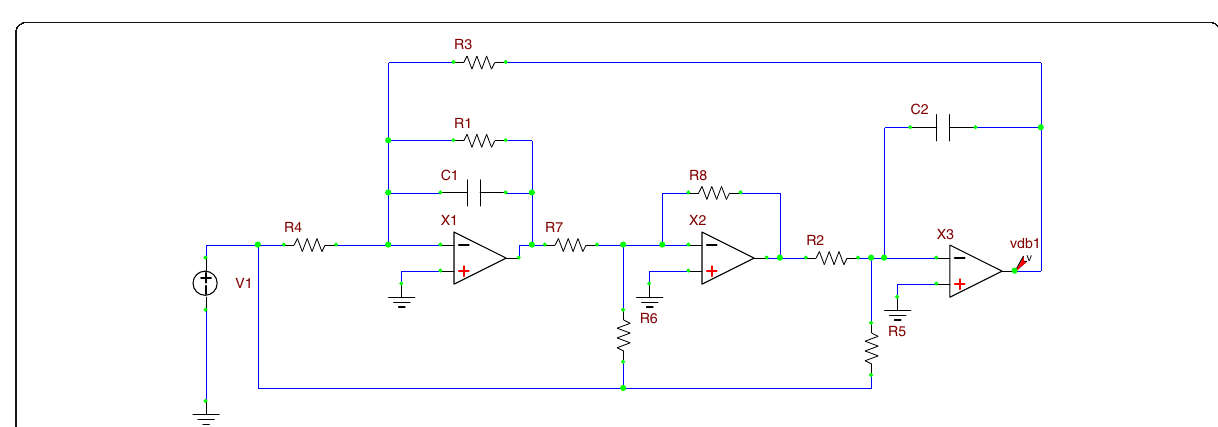
Fig. 6 The simulation of TT Bi-quad band-pass